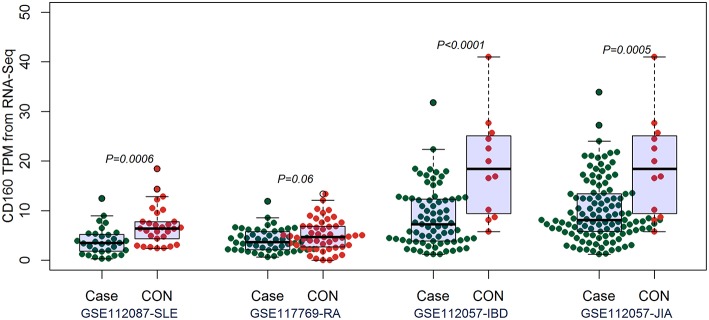
Validation of the aberrant expression of CD160 in SLE, RA, IBD, and JIA patients. The transcripts per million (TPM) value of CD160 were calculated from the raw read counts of four RNA-seq datasets including SLE (GSE112087), RA (GSE117769), IBD (GSE112057IBD), and JIA (GSE112057JIA), respectively. Difference between groups was analyzed using unpaired t-test. The aberrant expression of CD160 was statistically significant in SLE (P = 0.0006), IBD (P < 0.0001), and JIA (P = 0.0005), and was marginally significant in RA (P = 0.06).